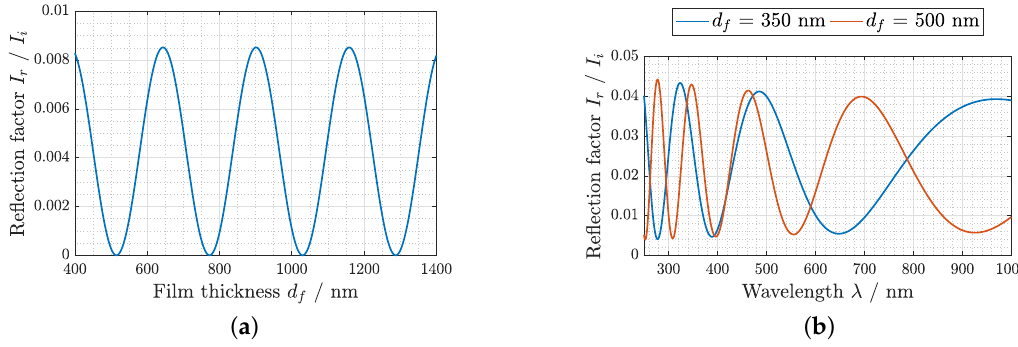
Figure 1. Plots of the analytical model for: ( a ) the laser interference setup for a wavelength of 635nm at an incident angle of 60.5 ◦ , which shows the relative reflected intensity over the thin-film thickness; and ( b ) the spectral reflectance at θ 0 = 37 ◦ for two exemplary thickness values d f .